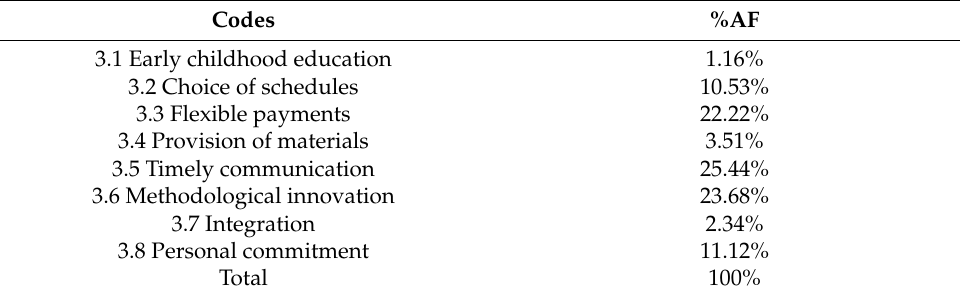
Table 3. Category 3 codes. Proposals for